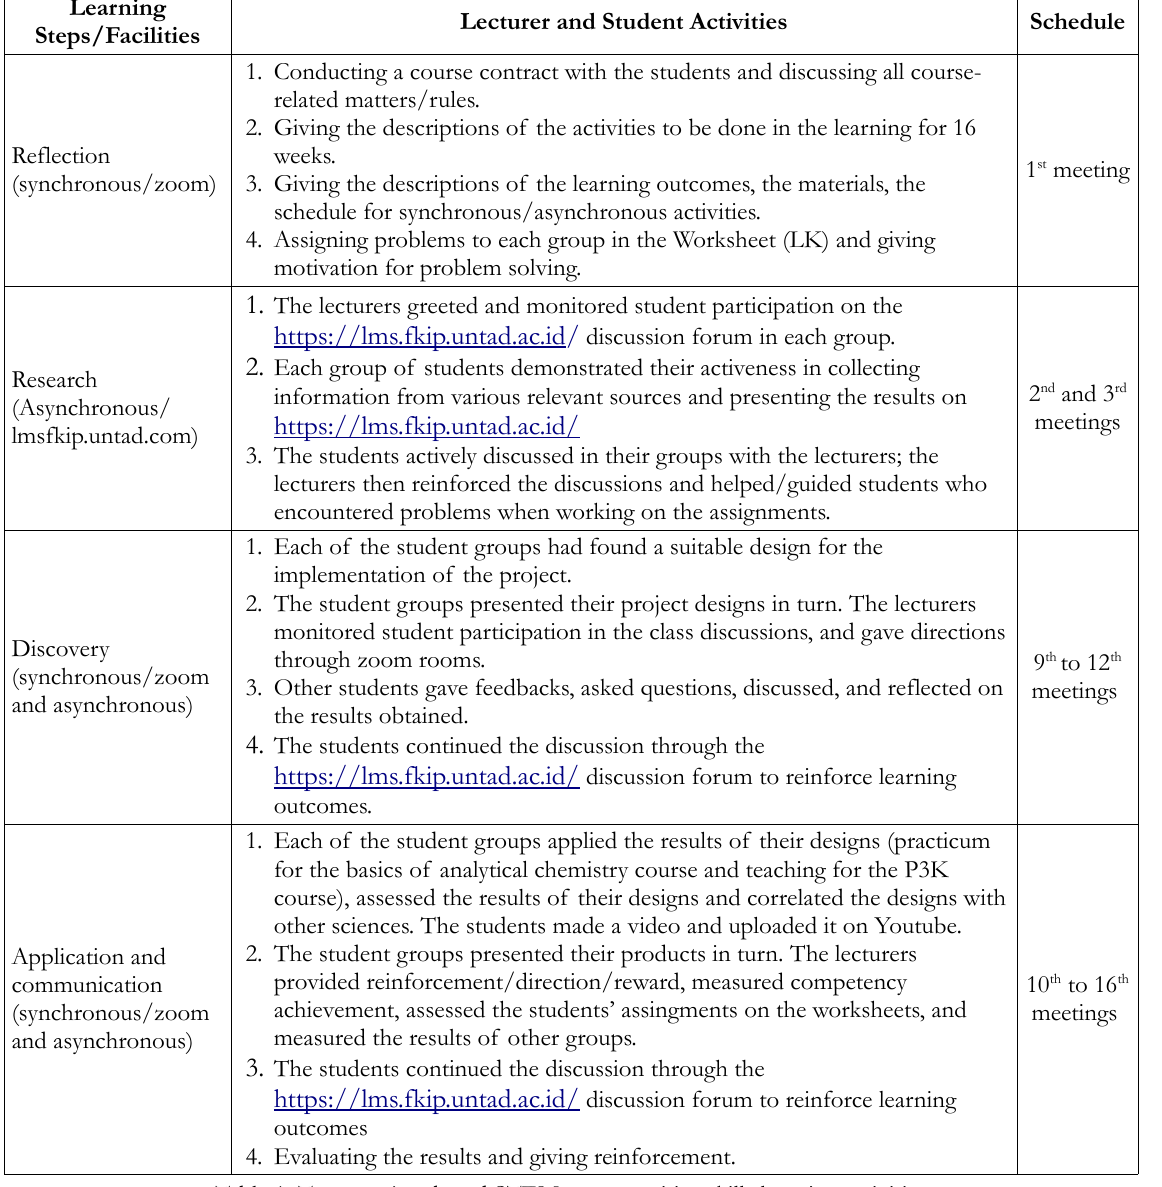
Table 1. Team project-based STEM-metacognitive skills learning